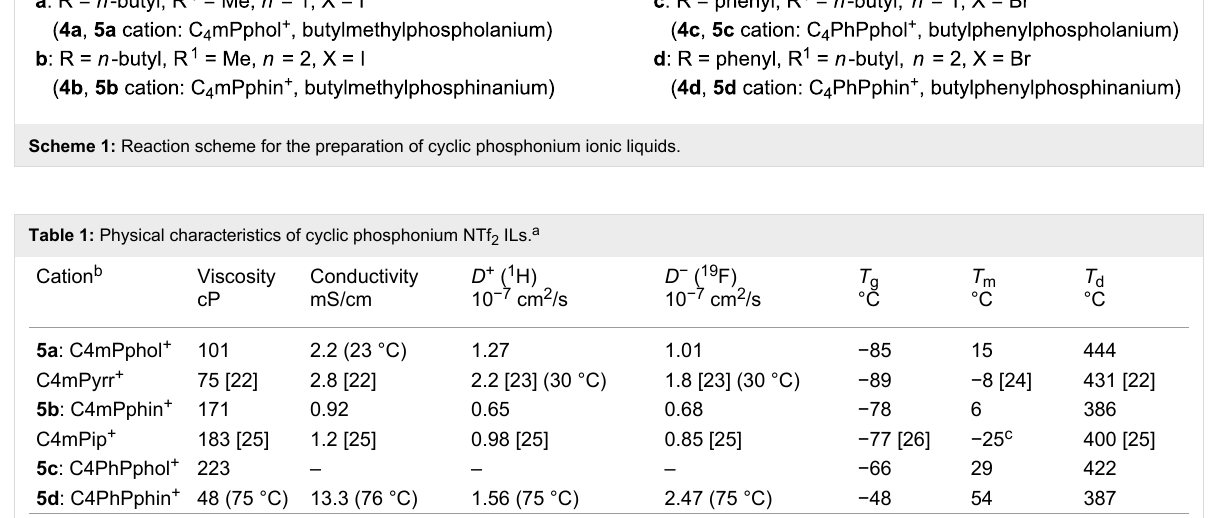
a All values are for measurements at 25 °C except where noted. Viscosities are calculated from VFT fits. All glass-transition temperatures ( T g ) and melting points ( T m ) are onset temperatures. Water contents of samples ranged from 76–155 ppm. Uncertainties of viscosities, conductivities, diffu- sion coefficients ( D + and D − ) are 1 cP, 7%, 5% and 1 °C respectively. T d is the thermal decomposition temperature. b Abbreviations and structures of ammonium congeners: